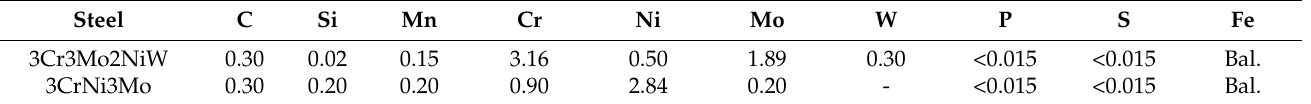
Table 1. Chemical composition of the test steels (mass fraction,